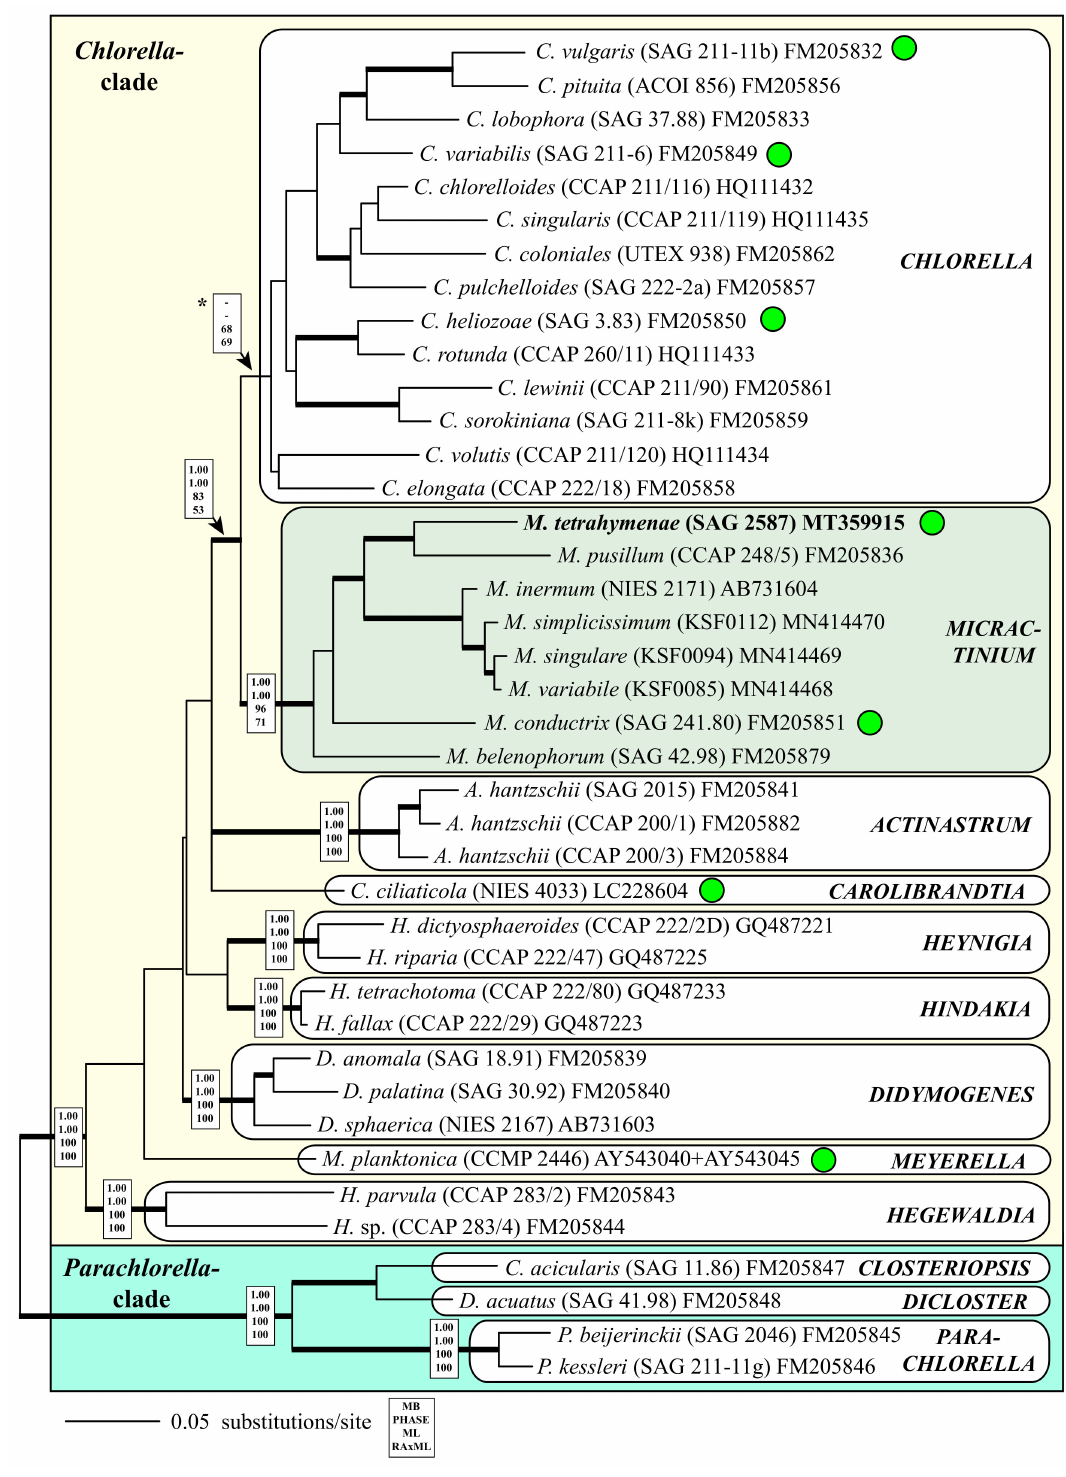
Figure 2. Comparison of the V9 of SSU and the conserved region of ITS-2 among the eight Micractinium species. Compensatory base changes (CBCs and HCBCs) and insertion / deletion are marked with an